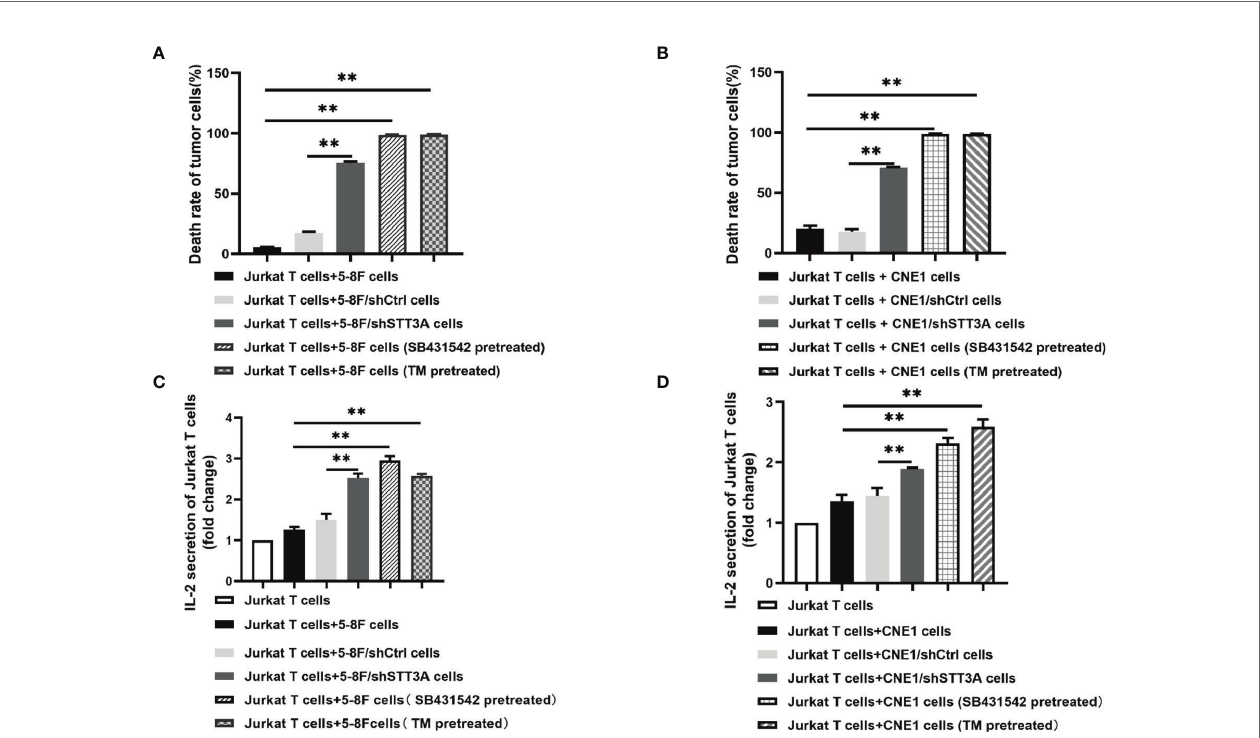
FIGURE 5 | Inhibition of TGF- b 1 by SB431542 suppressed T cells activity by inhibiting PD-L1 glycosylation in Vitro. (A, B) The death rate of 5-8F or CNE1 cells co- cultured with Jurkat T cells for 6h. The tumor cells were STT3A-kncokdowned by shRNA or pretreated with SB431542 (20 m M) or TM (10 m g/ml) for 48h. (C, D) IL-2 production by activated Jurkat T cells co-cultured with 5-8F or CNE1 cells with shSTT3A or pretreated with SB431542 (20 m M) or TM (15 m g/ml) for 48h. IL-2 secretion was measured by ELISA. Bars, mean ± SD, ** p